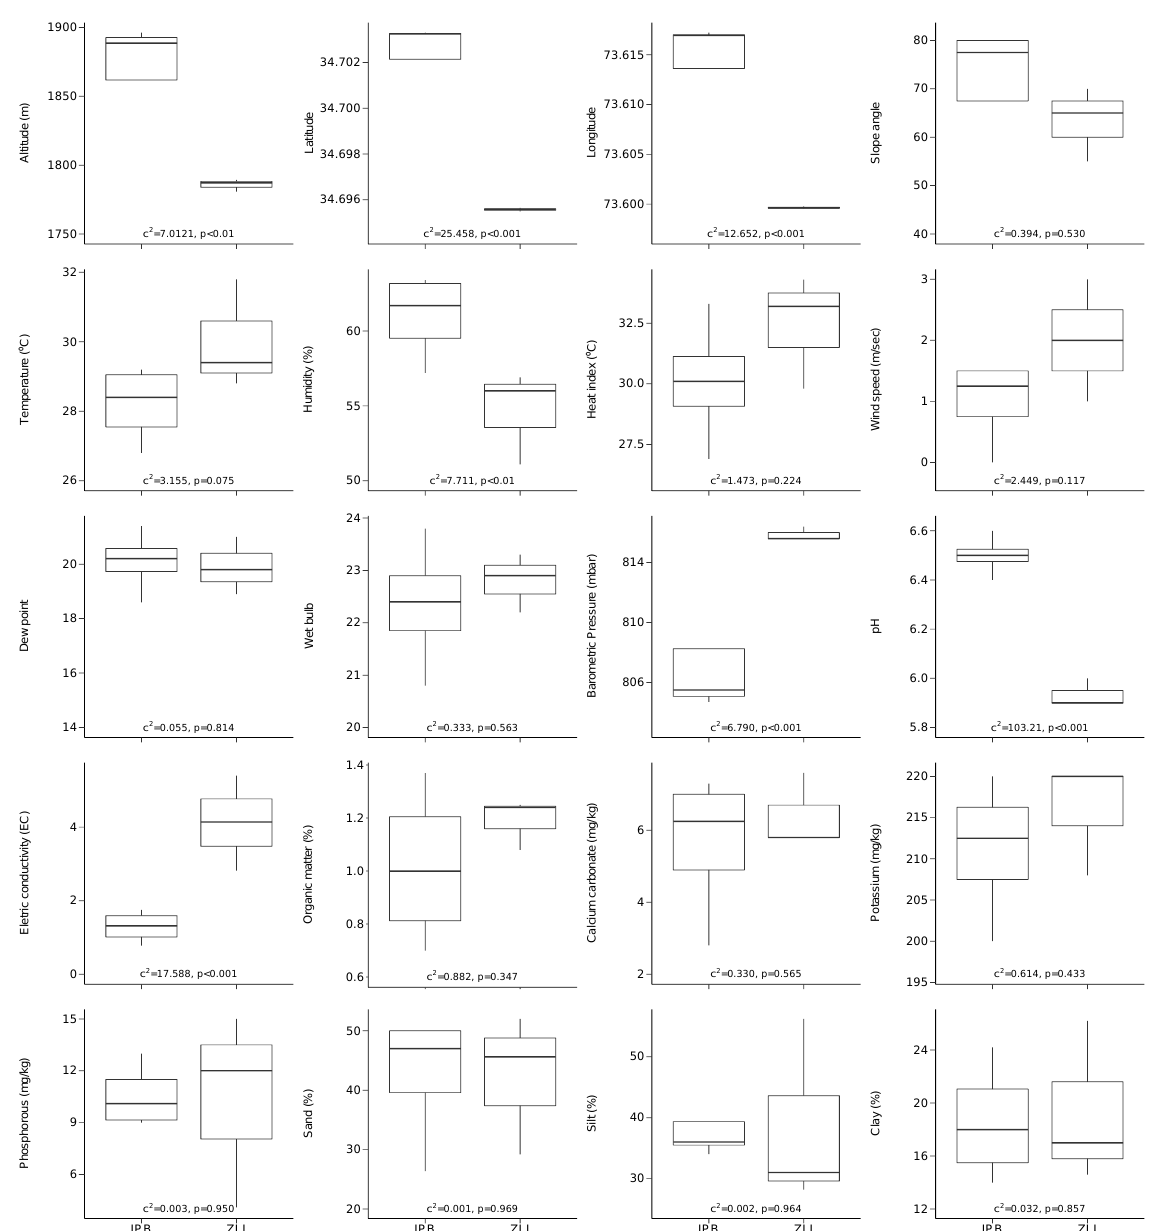
Figure 6. Variation of ecological parameters between the two plant communities evaluated in our study (GLM results, and associated p -values are displayed at each plot). Species richness values ranged from 30 and 87 species in two plant communities (Figure 7a). The highest number of plant species was reported in the IPB community (87 species) at 1789.6–1896.3 m altitude, followed by ZLQ (30 species) at the altitudinal range of 1780.8–1789.3m. The Shannon Diversity index values ranged between 2.4 and 4 (Figure 7b). The IPB community had the maximum value (H’ = 4), followed by the ZLQ community (2.4). The Simpson’s dominance index values ranged between 0.86–0.98. The IPB community had the maximum value (0.98) between the recorded communities. More- over, the lowest Simpson dominance value has been calculated for the ZLQ community (Figure 7c). The Pielou’s evenness index values ranged between 0.75 and 0.96 (Figure 7d). The IPB community had the maximum value (0.96); on the other hand, the ZLQ community had the lowest Pielous’s evenness